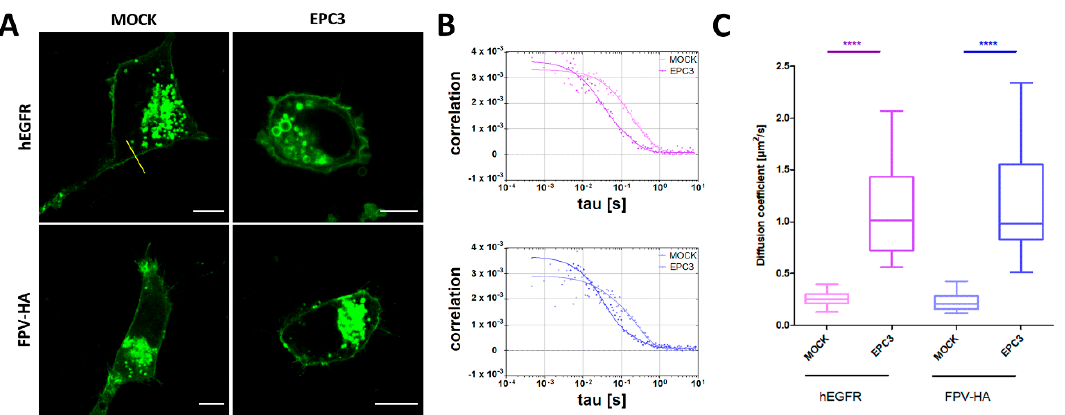
Figure 6. Quantification of protein di ff usion in EPC3-treated cells via scanning fluorescence correlation spectroscopy (sFCS). ( A ) Representative confocal fluorescence microscopy images of MDA-MB-231 cells expressing hEGFR-EGFP (upper row), and FPV-HA-EGFP (lower row), in the absence of EPC3 or after 48 h incubation with EPC3. The yellow line in ( A ) represents an example of scanning path used for sFCS measurements. Scale bars are 10 µ m; ( B ) Representative sFCS autocorrelation functions and fit curves obtained for cells expressing hEGFR-EGFP (upper graph) and FPV-HA-mEGFP (lower graph), in the absence of EPC3, or after 48 h incubation with EPC3. Fit curves (solid line) were obtained by fitting a two-dimensional di ff usion model to the data, as described in the Methods section; ( C ) Shows box plots of di ff usion coe ffi cients calculated from sFCS di ff usion times, pooled from three independent